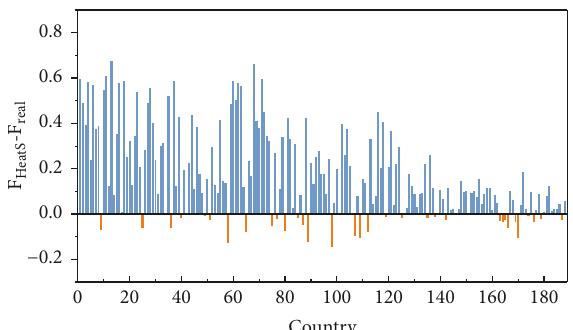
Figure 6: Difference of fitness resulting from following recommendation of HeatS and real evolution. The countries are sorted according to their fitness value, country 0 being the one with the highest average fitness. Each bar represents a country. The recommendation is performed at year 𝑇 for year 𝑇 + 5 , with 𝑇 ranging from year 2001 to 2010. 143 countries of the 181 countries would see their fitness improve by following the recommendation of